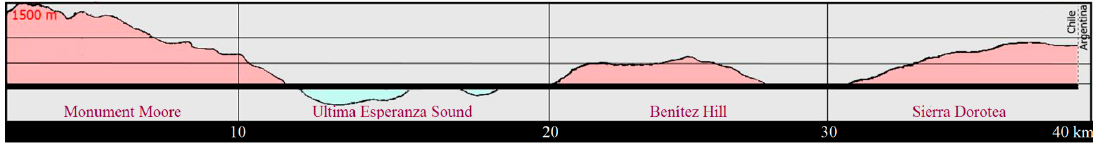
Figure 2. Location of the Benitez Hill and Ultima Esperanza Sound in a schematic geomorphological profile from the Monument Moore hill (west) to Sierra Dorotea on the Chile–Argentina border (east). Graphic design in Figures 2, 3, 6 and 7, and 18: H. G. Nami and G. Paez Reina.